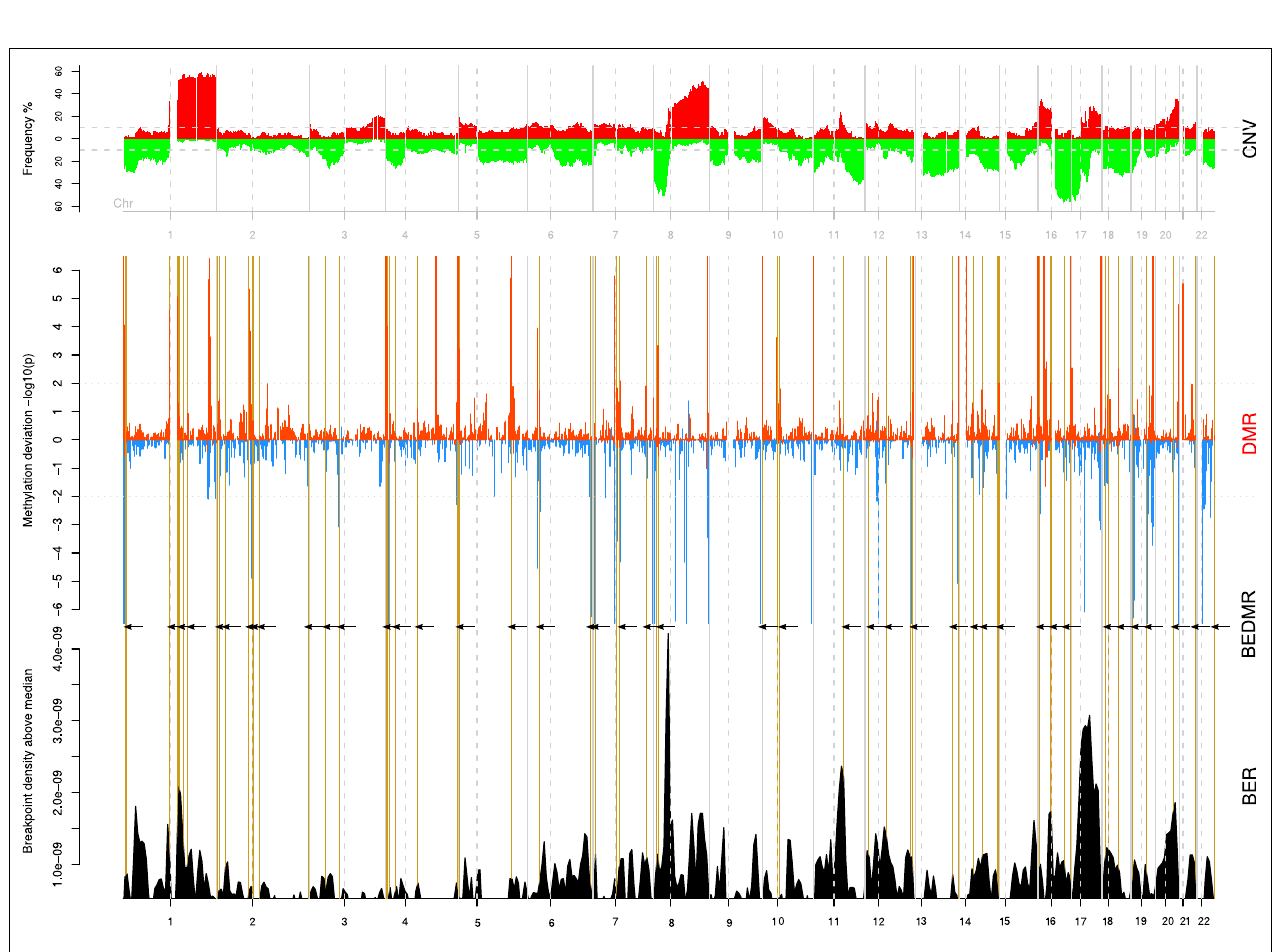
while hyper-methylated regions take a score equal to − log( p ). Significant DMRs are marked by peaks with a score greater than ± 2.The bottom track (BER) shows the locations of breakpoint enriched regions. Breakpoint enriched DMRs (BEDMR), i.e., DMRs occurring in the vicinity of a BER are marked by vertical yellow lines and black